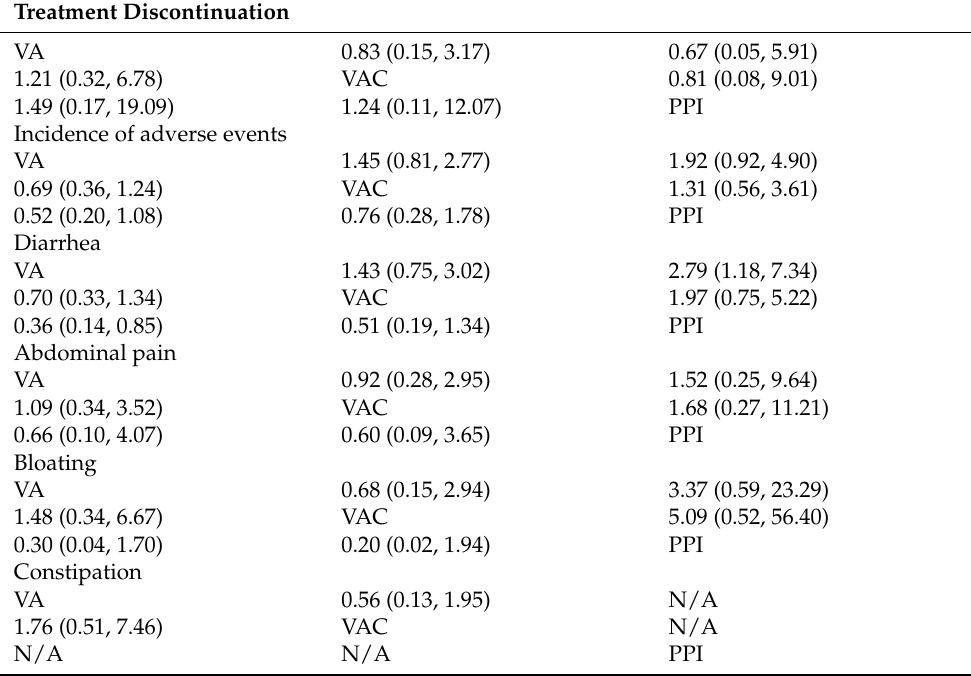
Table 4. SUCRA-based efficacy ranking league matrix showing the comparative safety of the regimens included in this Network Meta-Analysis.